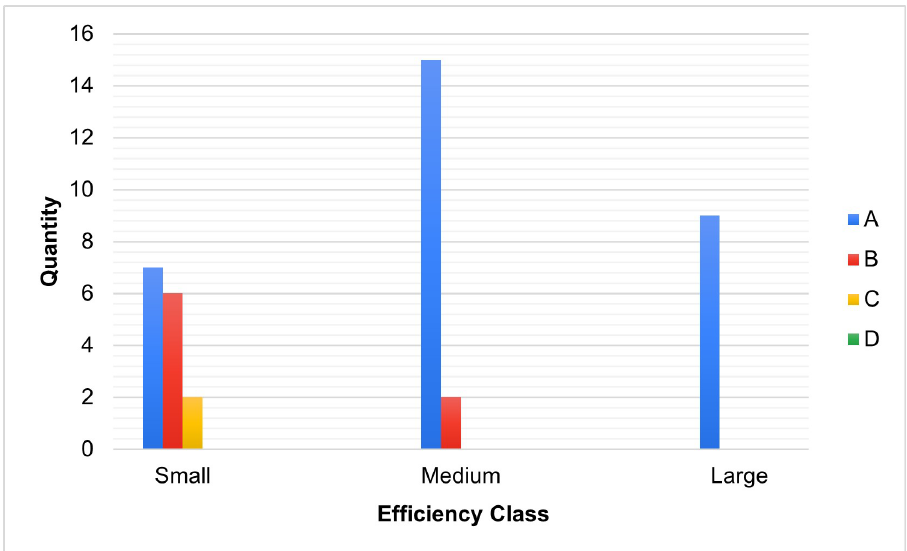
Figure 9. Efficiency Ranges for Residential Refrigerators Categorized as Tropical [T].